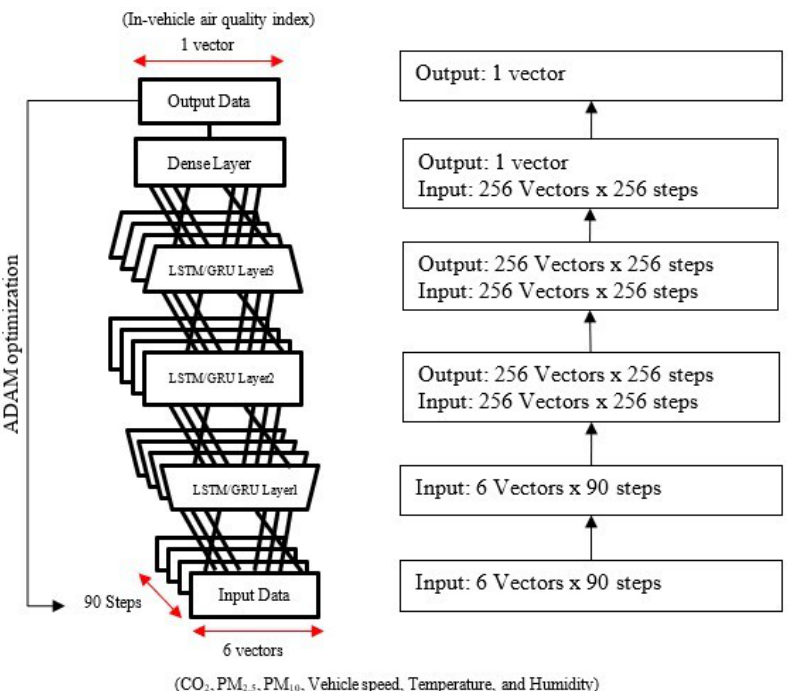
Figure 7. Prediction of Multiple Sequence using GRU and LSTM.